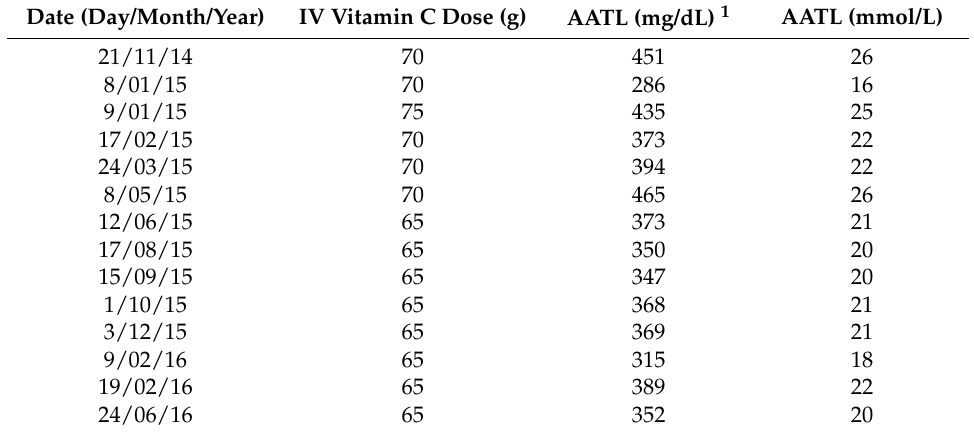
Table 1. Intravenous vitamin C dosage infused into the patient and post-infusion ascorbic acid therapeutic level in blood plasma.